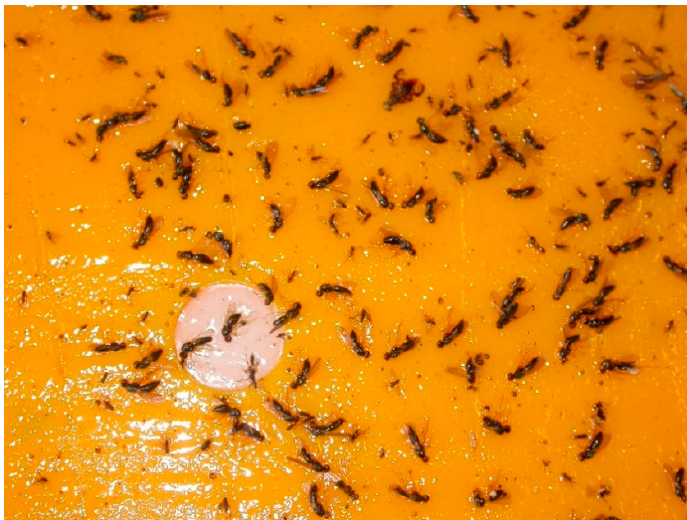
Figure 1. Adult Chamaepsila rosae on Rebell ® (Andermatt Biocontrol AG, Grossdietwil, Switzerland) sticky trap (image provided by Rosemary Collier, University of Warwick, Warwick, UK) .